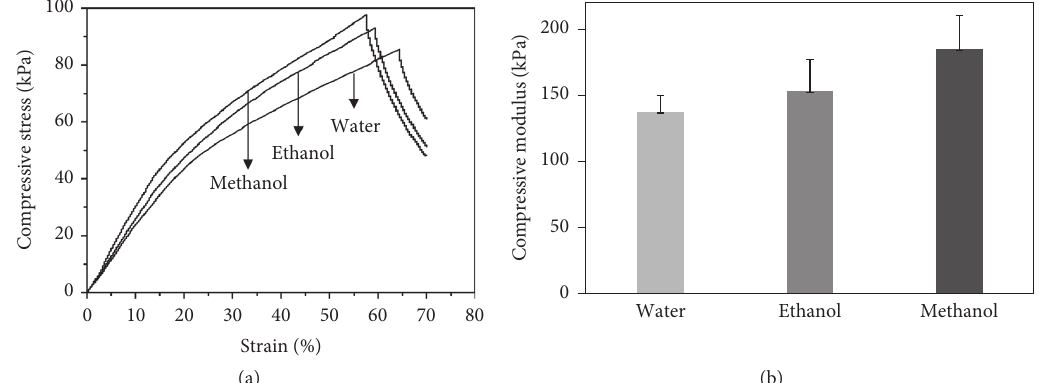
Figure 5: The stress-strain curves (a) and compressive modulus (b) of silk scaffolds post-treated with methanol, ethanol, and